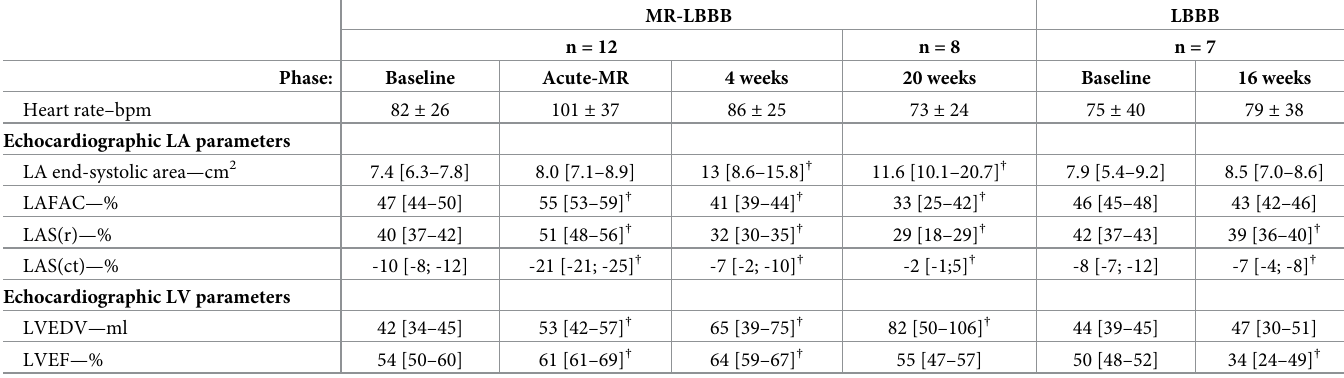
Table 1. Overview of echocardiographic and hemodynamic measurements at baseline, acute, subacute, and chronic